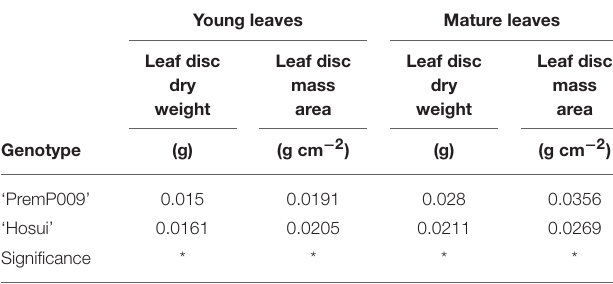
Frontiers in Plant Science |